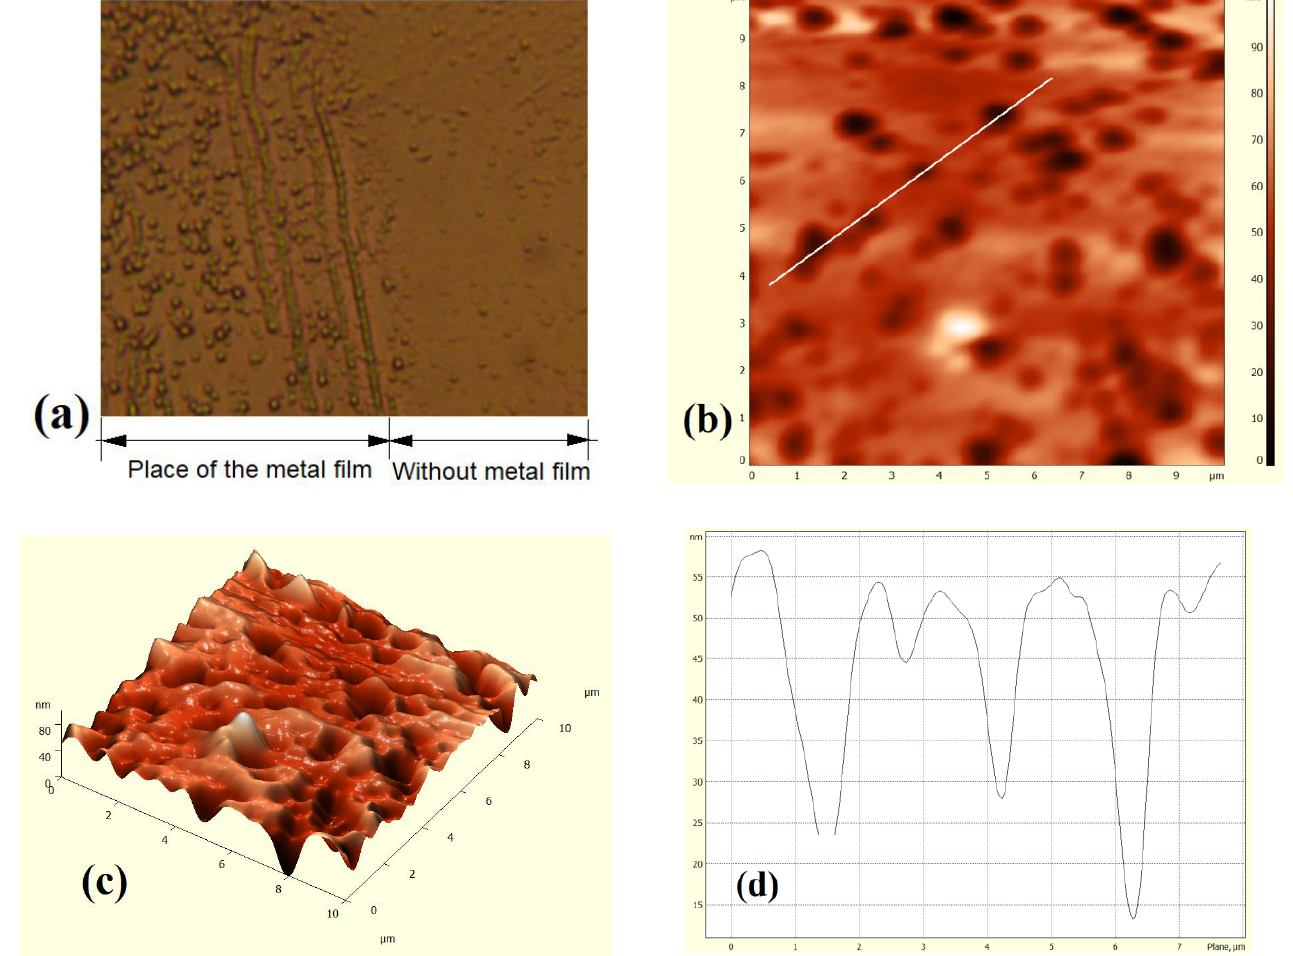
Figure 6. Structural studies of the silicon (111) surface: microphotography of the silicon surface taken with an LUMAM I-3 optical microscope (x 150) ( a ); silicon morphology (from the side where the covered metal film was previously) obtained using a Solver P47-PRO atomic-force microscope ( b – d ).